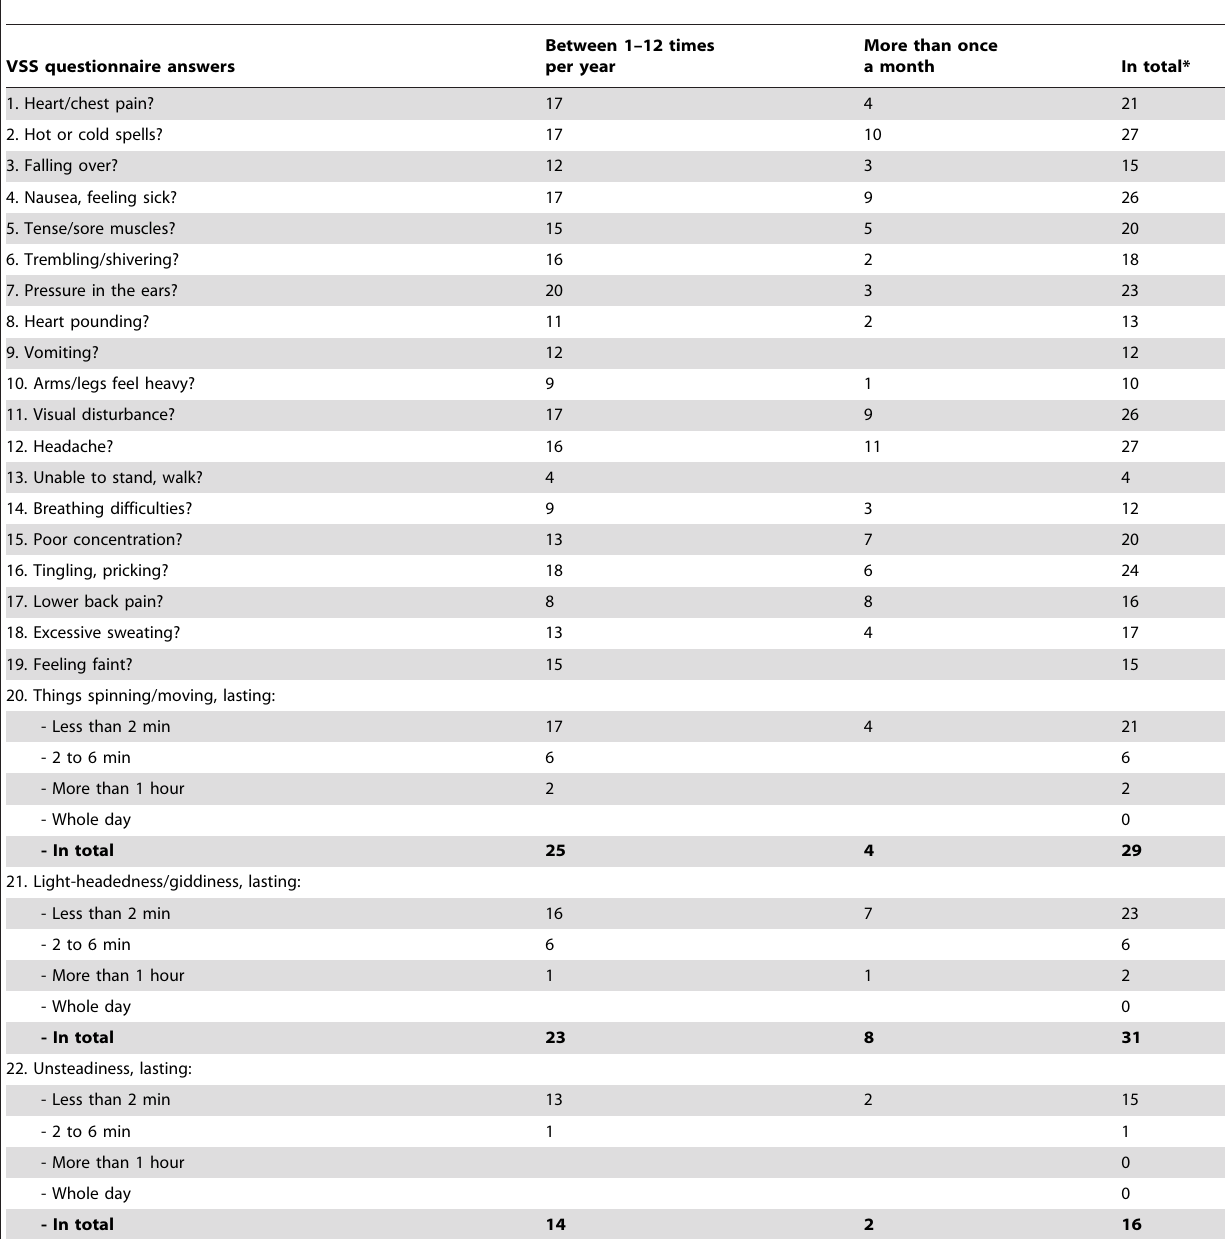
Table 5. VSS questionnaire answers from the meningitis subjects (n=36) to the question: ‘‘How often during the last 12 months have you had the following